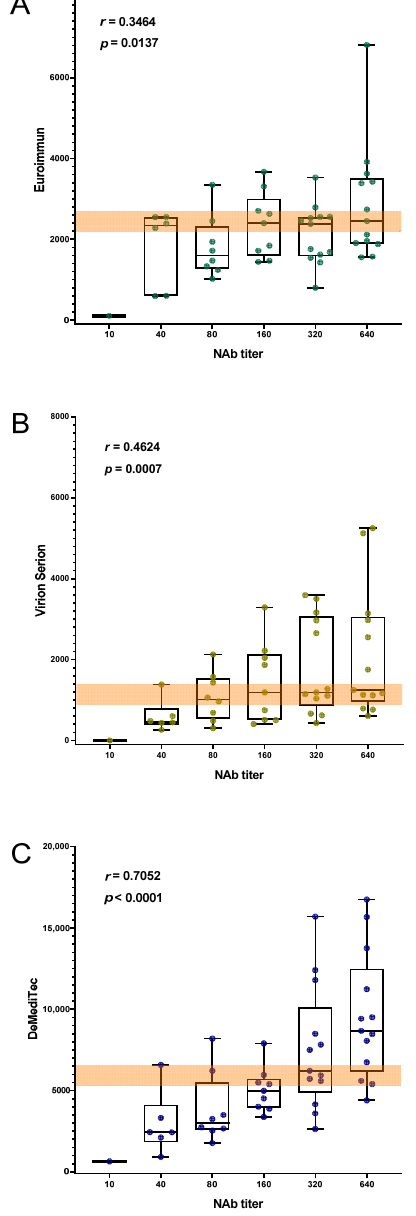
Figure 2. Distribution of immunoassay results and neutralizing antibody titers. Spearman’s rank coefficients ( r ) and their corresponding p values are indicated for each assay. Whiskers extend from minimal to maximal values and all points are shown. Agreement between Euroimmun and NT ( A ) as well as Virion Serion and NT ( B ) was fair to middling while it was good between DeMediTec and NT ( C ). The highlighted areas indicate exemplary samples with significantly different NT titers despite apparently very similar ELISA antibody unit